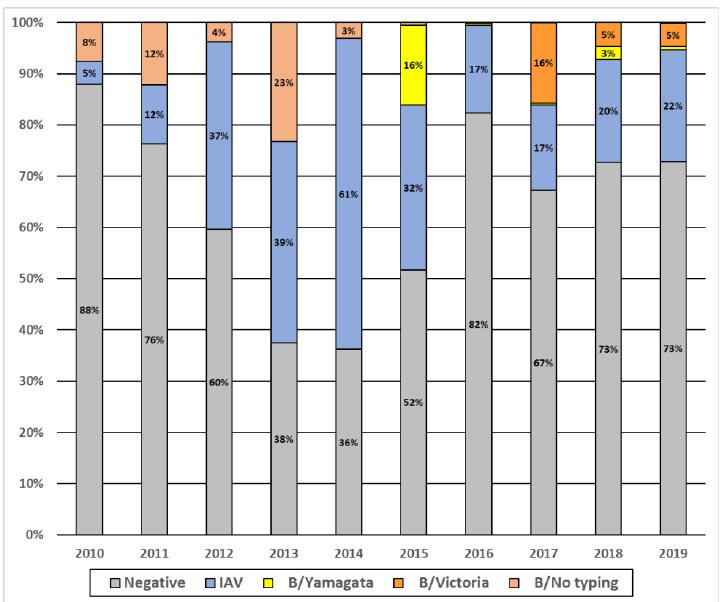
Figure 1. Annual prevalence of influenza viruses A and B in Senegal, 2010 – 2019.